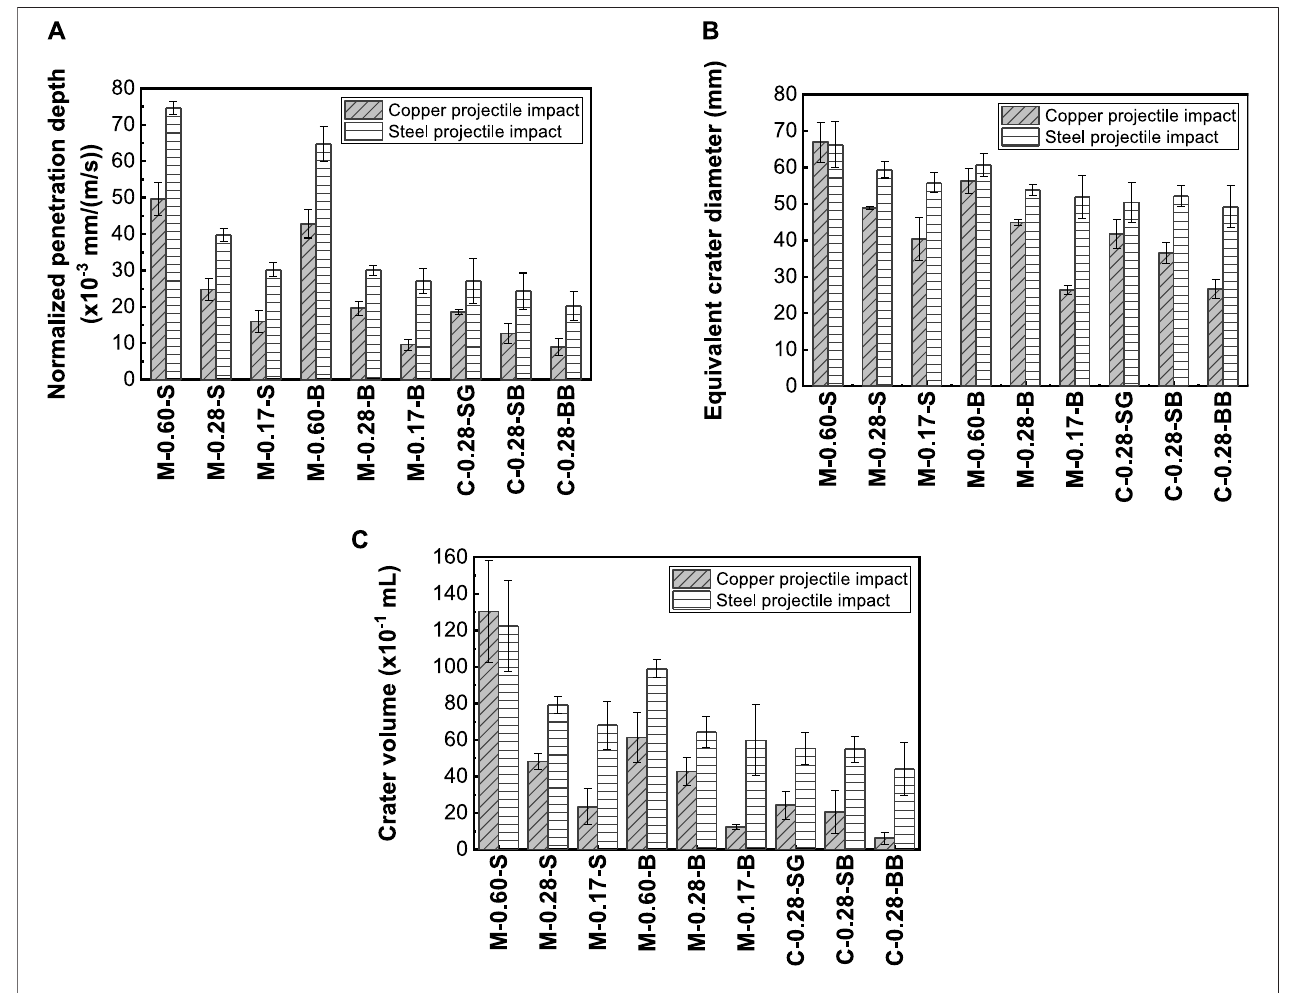
FIGURE 6 | Comparison of the normalized damage characteristics of cement composites, (A) DOP, (B) CD, and (C) CV.